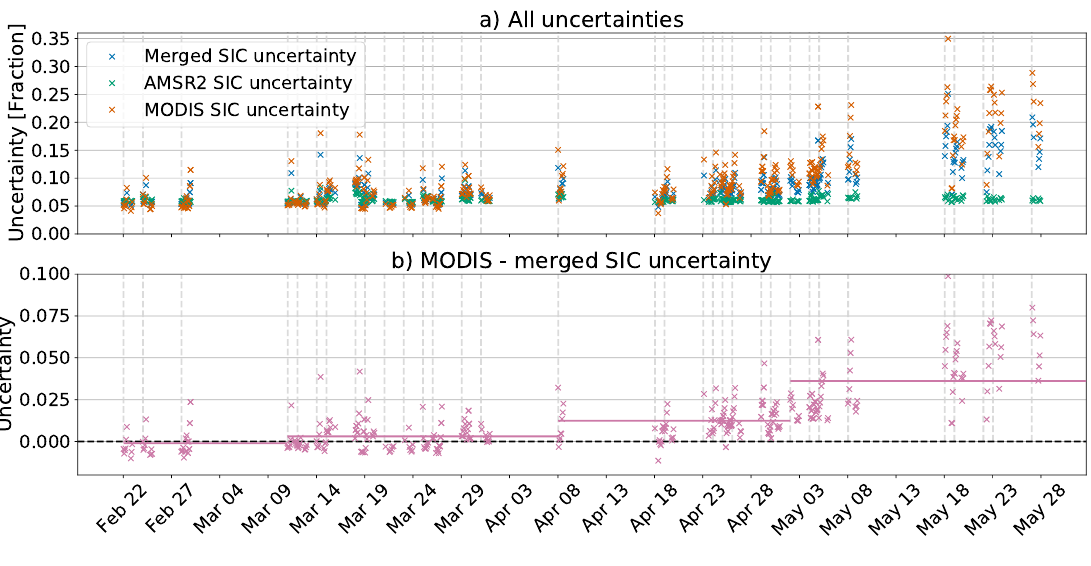
Figure 13. The mean uncertainty of the merged, AMSR2 and MODIS SIC is shown in panel ( a ). Panel ( b ) shows the difference between the MODIS SIC and the merged SIC uncertainty, the monthly mean difference is shown as solid horizontal line. The uncertainty is given as a fraction of 1. The x-axis shows the date, the vertical lines mark the days with Sentinel-2